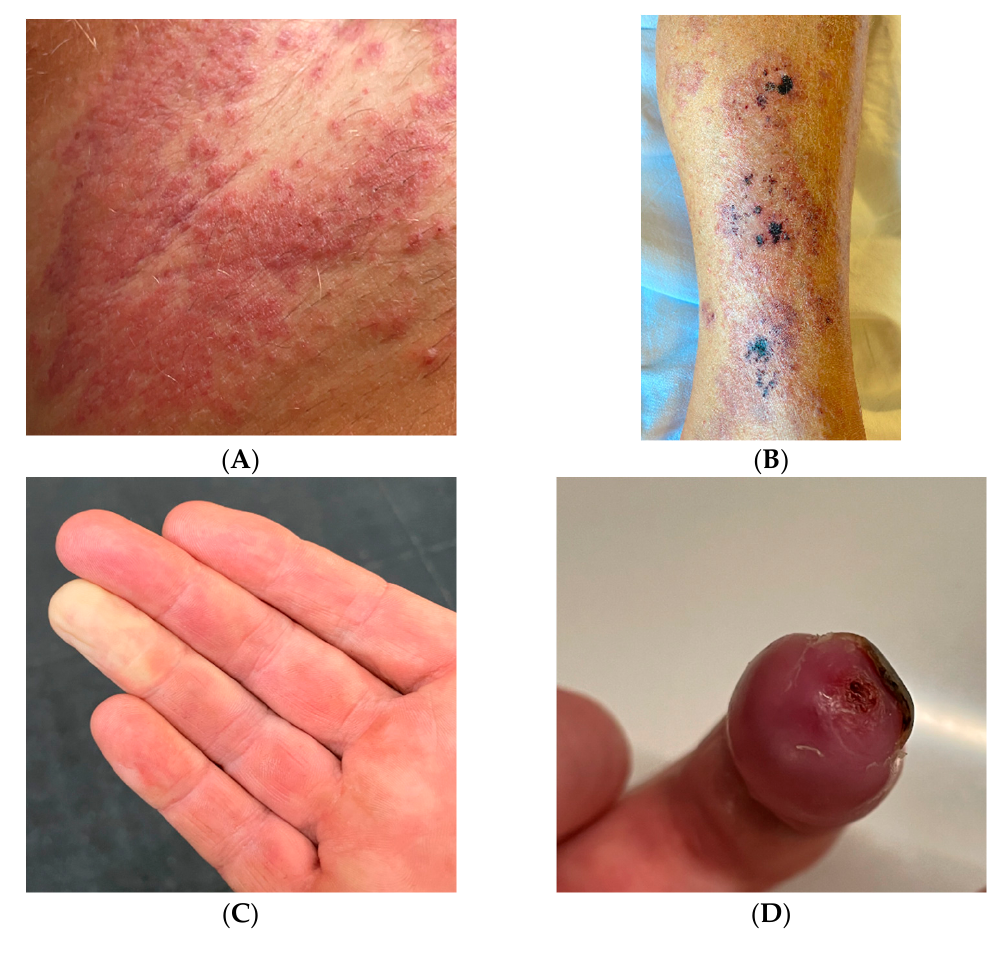
Figure 1. ( A ) Maculo-papular erythematous eruption on the trunk; ( B ) nodular purpuric lesions on the right leg; ( C ) Raynaud’s phenomenon; ( D ) acrocyanosis and gangrenous lesions at the tip of the fourth finger of the right hand.